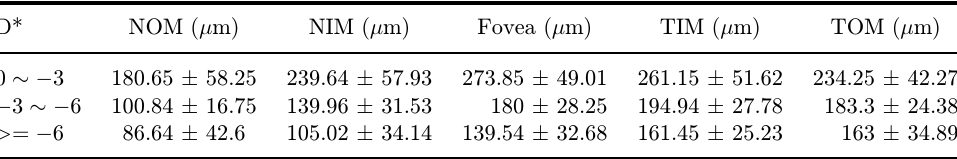
Table 2. CT in di®erent positions under conditions of low, moderate and high myopia. Data are presented as mean (cid:4) STD.